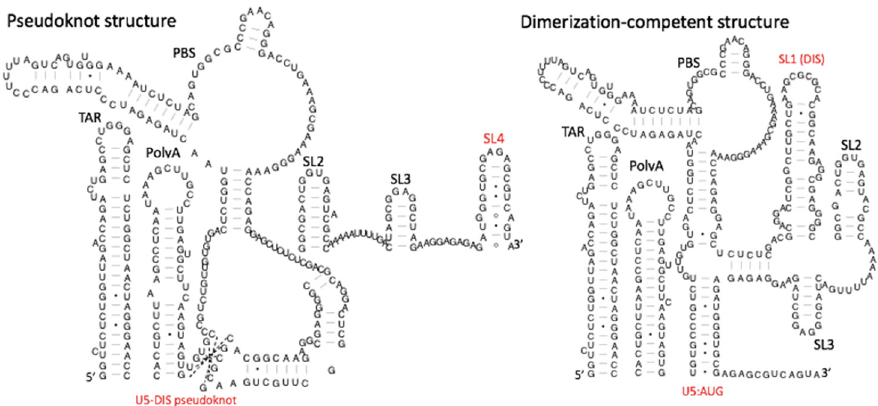
Figure 1. The HIV-1 genomic RNA leader contains a structural switch. Left hand panel: pseudoknot structure, where the DIS palindrome forms a pseudoknot with upstream U5 sequences. Right hand panel: the same U5 sequence pairs with the Gag start codon to form the U5:AUG helix. Structures that change during the switch are labelled in red. Structures are drawn according to data from Kenyon et al.,